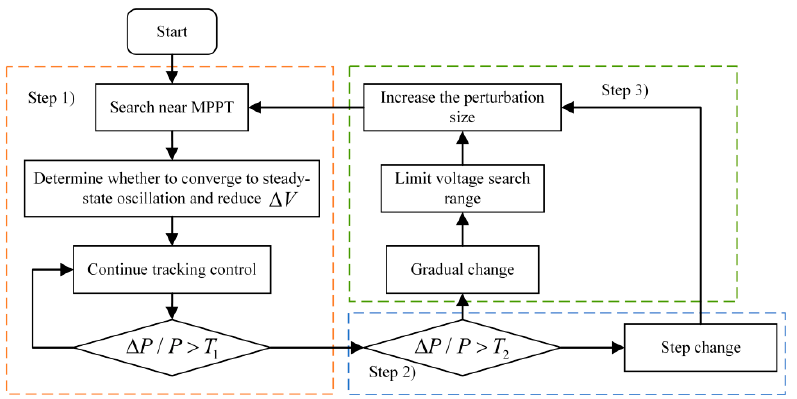
Figure 13. Flowchart of the improved P&O algorithm.